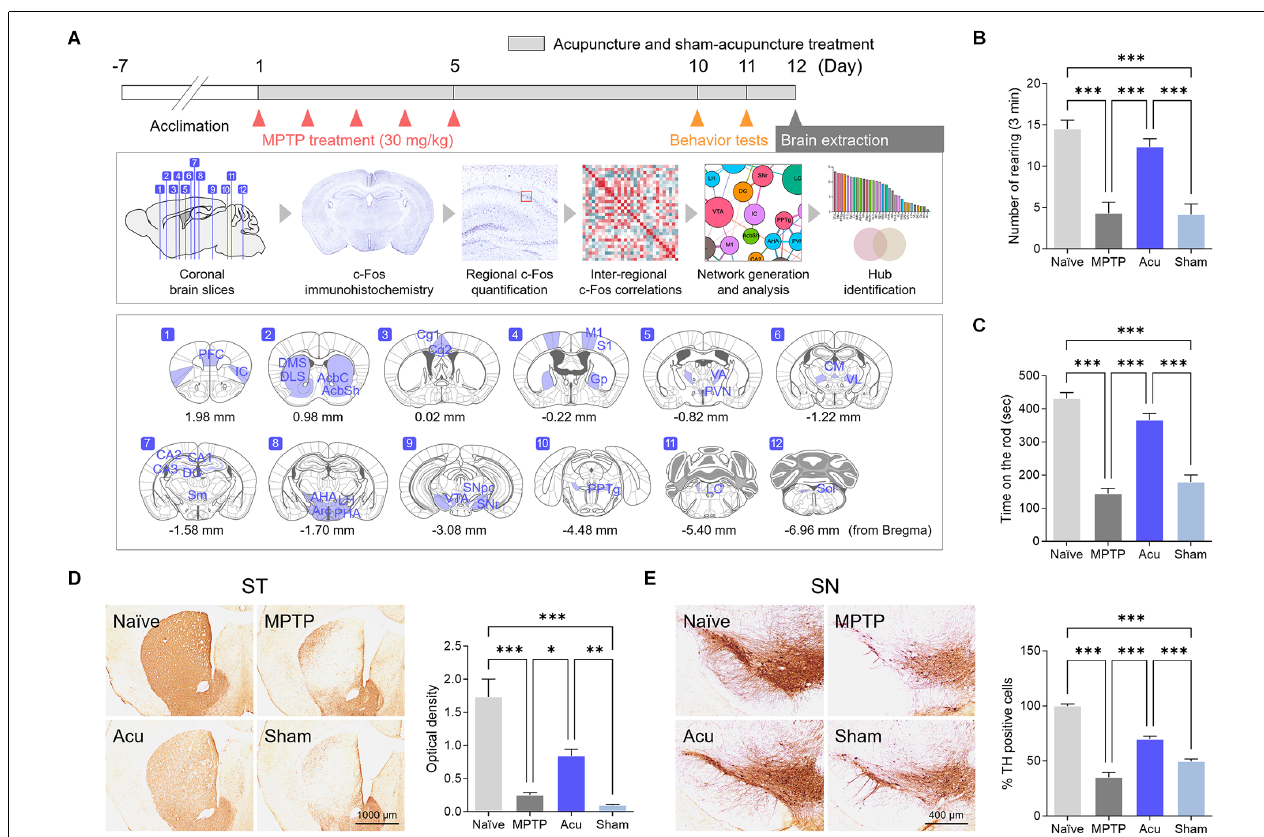
FIGURE 1 | Acupuncture alleviates parkinsonian motor deficits and improves nigrostriatal TH loss in the MPTP-induced PD model. (A) Experimental timeline of functional connectivity study. Acupuncture was performed at GB34 for 12 days. Motor behavior tests were performed on days 10 and 11 after the first injection of MPTP (30 mg/kg). To confirm the brain neural responses and brain functional connectivity, the brains were removed 90 min after acupuncture treatment. The c-Fos-positive cells were quantified in each of the 30 brain regions, and functional networks were generated after a series of inter-regional correlations were computed. (B,C) Motor behavior evaluated by cylinder and rotarod tests. Acupuncture rescued motor behavior in MPTP-treated animals, but not sham acucpuncture. (D,E) Representative images of TH-stained ST and SN tissue and quantification of TH optical density and number of TH-positive cells. Acupuncture markedly alleviates TH loss in ST and TH-positive dopaminergic neurons in the SN of MPTP-treated mice. n = 6/group, ∗∗∗ p < 0.001, ∗∗ p < 0.01, ∗ p < 0.05. All data are mean ± SEM following the one-way ANOVA followed by the Tukey’s